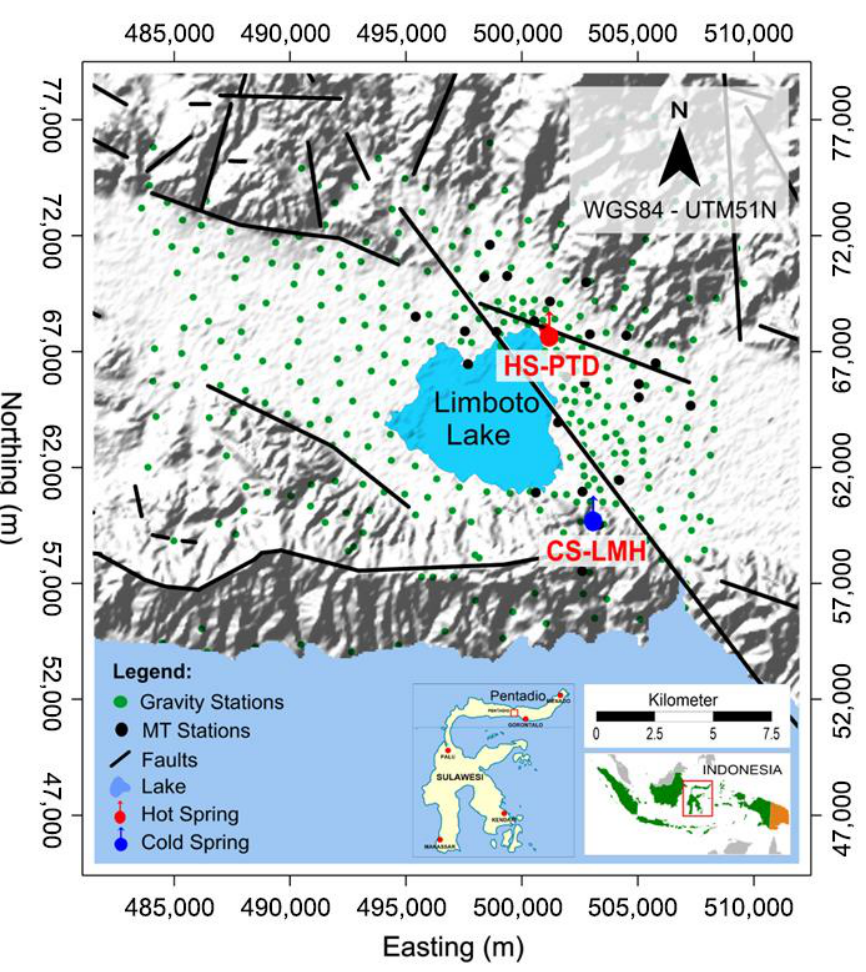
Figure 3. Location of MT and gravity stations in the Limboto Lake—Pentadio Area. The black dots depict the distribution of MT stations, and the green dots depict the distribution of gravity stations. The red dot represents the location of the hot spring, and the blue dot represents the cold spring.